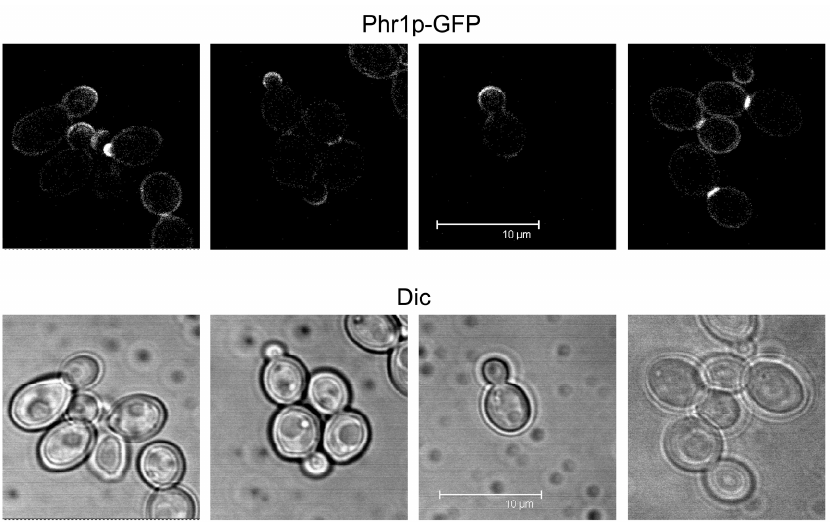
Figure 6. Localization of Phr1p-GFP in C. albicans . Cells growing in YPD-150 mM HEPES pH 7.5 at 25 °C.